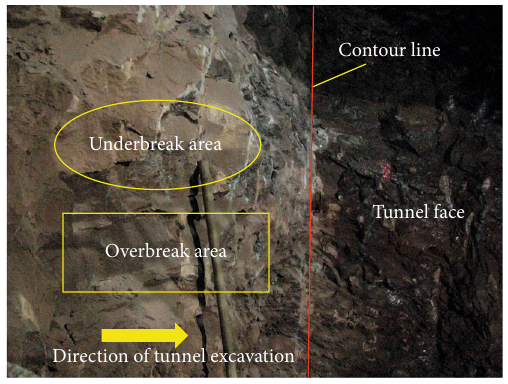
Figure 2: Adverse geological structures induced overbreak and